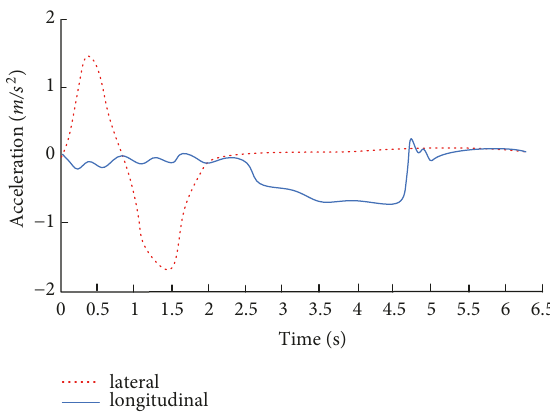
Figure 8: Longitudinal and transverse acceleration variation curve.